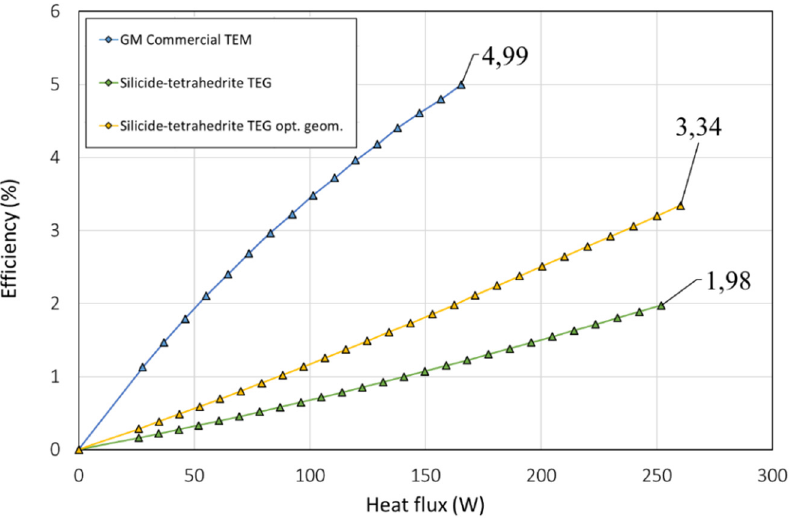
Figure 6. Efficiency of the TEM as a function of the heat flux (IFDM 1D).